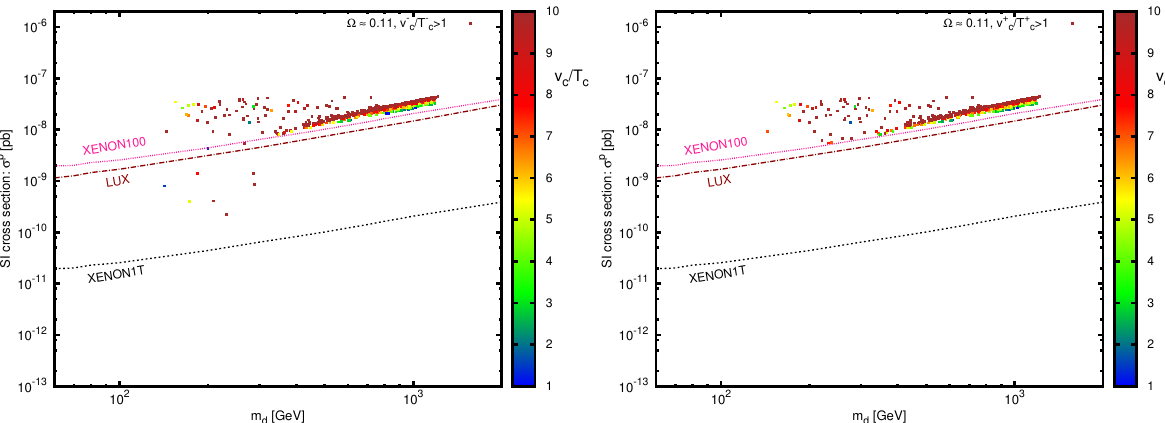
Figure 2 . The allowed DM mass, m d , against the Yukawa coupling, g d , in the fermionic dark matter scenario with scalar mediator, bounded from the relic density, (cid:12)rst-order phase transition condition, and the direct detection bound by XENON100/XENON1T/LUX for left) v (cid:0) with DM mass in the range 150{300 GeV for XENON100/LUX and no viable DM mass for the future direct detection bound by XENON1T right) v +